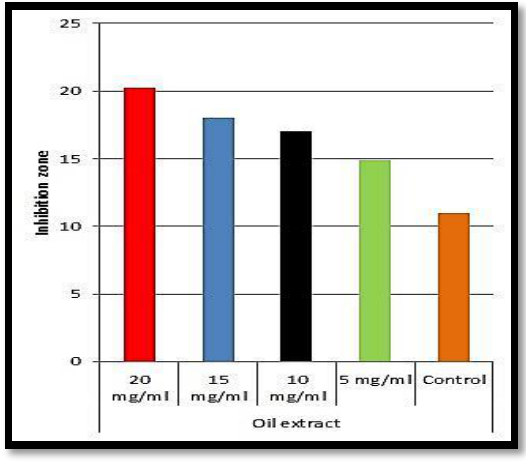
Figure 1: Antifungal activity of Nasturtium officinale oil and calcium hydroxide paste (control) against Candida albicans . Table 1: Comparison among the antifungal activity (inhibition zone diameter in mm) of Nasturtium officinale oil and calcium hydroxide paste (control) against Candida albicans . Oil Conc.